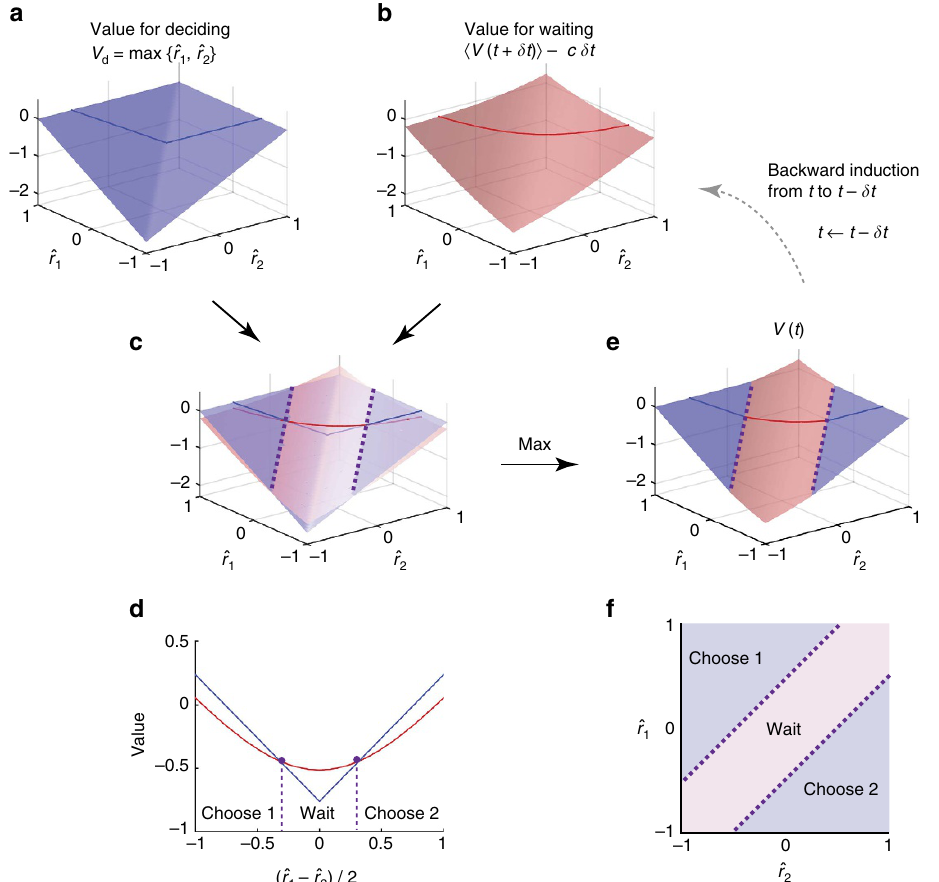
Figure 3 | Finding the decision boundaries in value-based decision. ( a ) The expected values of choosing either option are defined as a two-dimensional function (surface), max ^ r 1 ; ^ r 2 f g , of a pair of reward estimates, ^ r 1 ; ^ r 2 ð Þ , at time t . The dark coloured line shows the section at ^ r 1 þ ^ r 2 ¼ 0 : 5. ( b ) Similarly, the value surface for ‘waiting’ (that is, the expected value after observing new evidence for a short period d t , subtracted cost for waiting c d t ) is defined as a function of ^ r 1 ; ^ r 2 ð Þ . Note that, around the diagonal, ^ r 1 ¼ ^ r 2 , the value for waiting is smoother than that for choosing due to the uncertainty about future evidence. ( c , d ) The value surfaces for choosing and waiting superimposed, and their sections at ^ r 1 þ ^ r 2 ¼ 0 : 5. The decision boundaries (dotted lines) are determined by points in the space of reward estimates in which the value for ‘deciding’ (blue) equals that for waiting (red). In the region where waiting has a higher value than choosing either option (blue below red curve/surface), the decision maker postpones the decision to accumulate more evidence; otherwise, she chooses the option that is expected to give the higher reward. Because the relationship between the two value surfaces is translational symmetric in terms of mean reward ^ r 1 þ ^ r 2 intersections are parallel and do not depend on this mean reward. ( e ) The expected value V ( t ) is given by the maximum of the values for choosing and waiting. This surface determines the value for waiting ( b ) at the next-earlier time step, t (cid:3) d t . ( f ) Decision boundaries and associated choices shown in the two- dimensional ^ r 1 ; ^ r 2 ð Þ representation. Note that the two boundaries are always parallel to the diagonal, ^ r 1 ¼ ^ r 2 . This is because the both value functions (for deciding and for waiting) are linearly increasing with slope one in lines parallel to the diagonal ( a , b ). For the value for deciding, for example, below the diagonal we have ^ r 1 4 ^ r 2 , such that V d ^ r 1 ; ^ r 2 ð Þ ¼ ^ r 1 , and therefore V d ^ r 1 þ C ; ^ r 2 þ C ð Þþ C , where C is an arbitrary scalar. The value for waiting can be shown to have the same